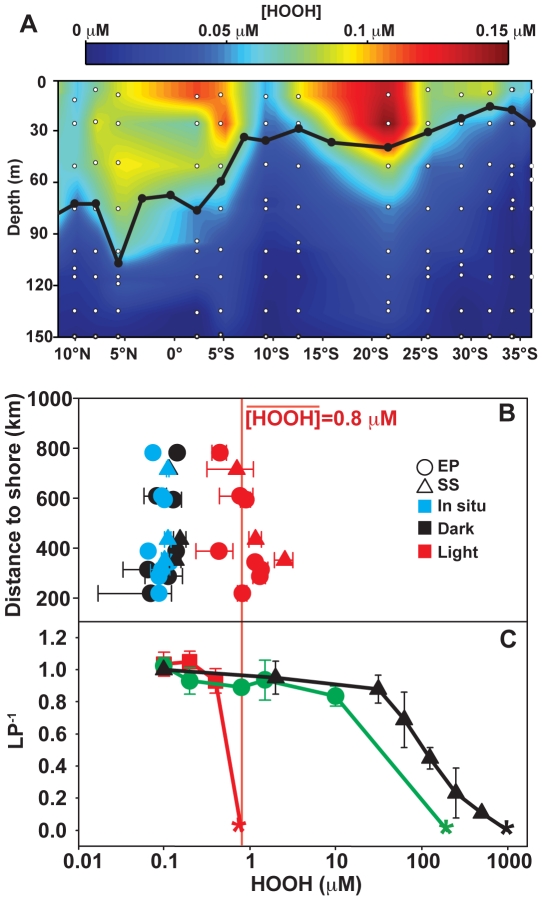
Removal of HOOH is necessary for Prochlorococcus survival at the ocean's surface.A) [HOOH] in the euphotic zone along a transect from Hawai'i to Australia, Jan-Feb 2007. Sampled depths (open circles) used in the linear interpolation of HOOH, and surface mixed layer depth (black line) are reported. B) Effect of solar irradiation on [HOOH] of seawater. “Light” and “Dark” indicate HOOH concentrations after 24 h incubations as described in Methods. Vertical line represents the mean [HOOH] in light incubations, represented by the SMC value as described in the text. EP, Eastern Pacific stations; SS, Sargasso Sea stations. C) Effect of HOOH exposure on the long-term growth of Prochlorococcus UH18301 cultures. Lag phase duration, expressed as the inverse ratio of each sample to a no added HOOH control (LP−1) as a function of HOOH dosage with (green circles) or without (red squares) EZ55. Black triangles, LP−1 of EZ55 in YT3 medium; *, all replicate cultures failed to show detectable growth after 60 d. Error bars are the standard error of three biological replicates. Cultures were grown under low light with an initial inoculum of ∼105 cells mL−1.